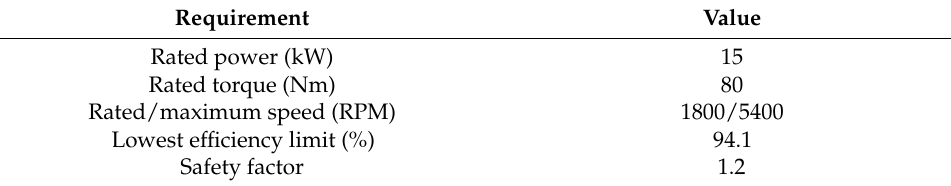
Table 1. Requirements of an objective motor.